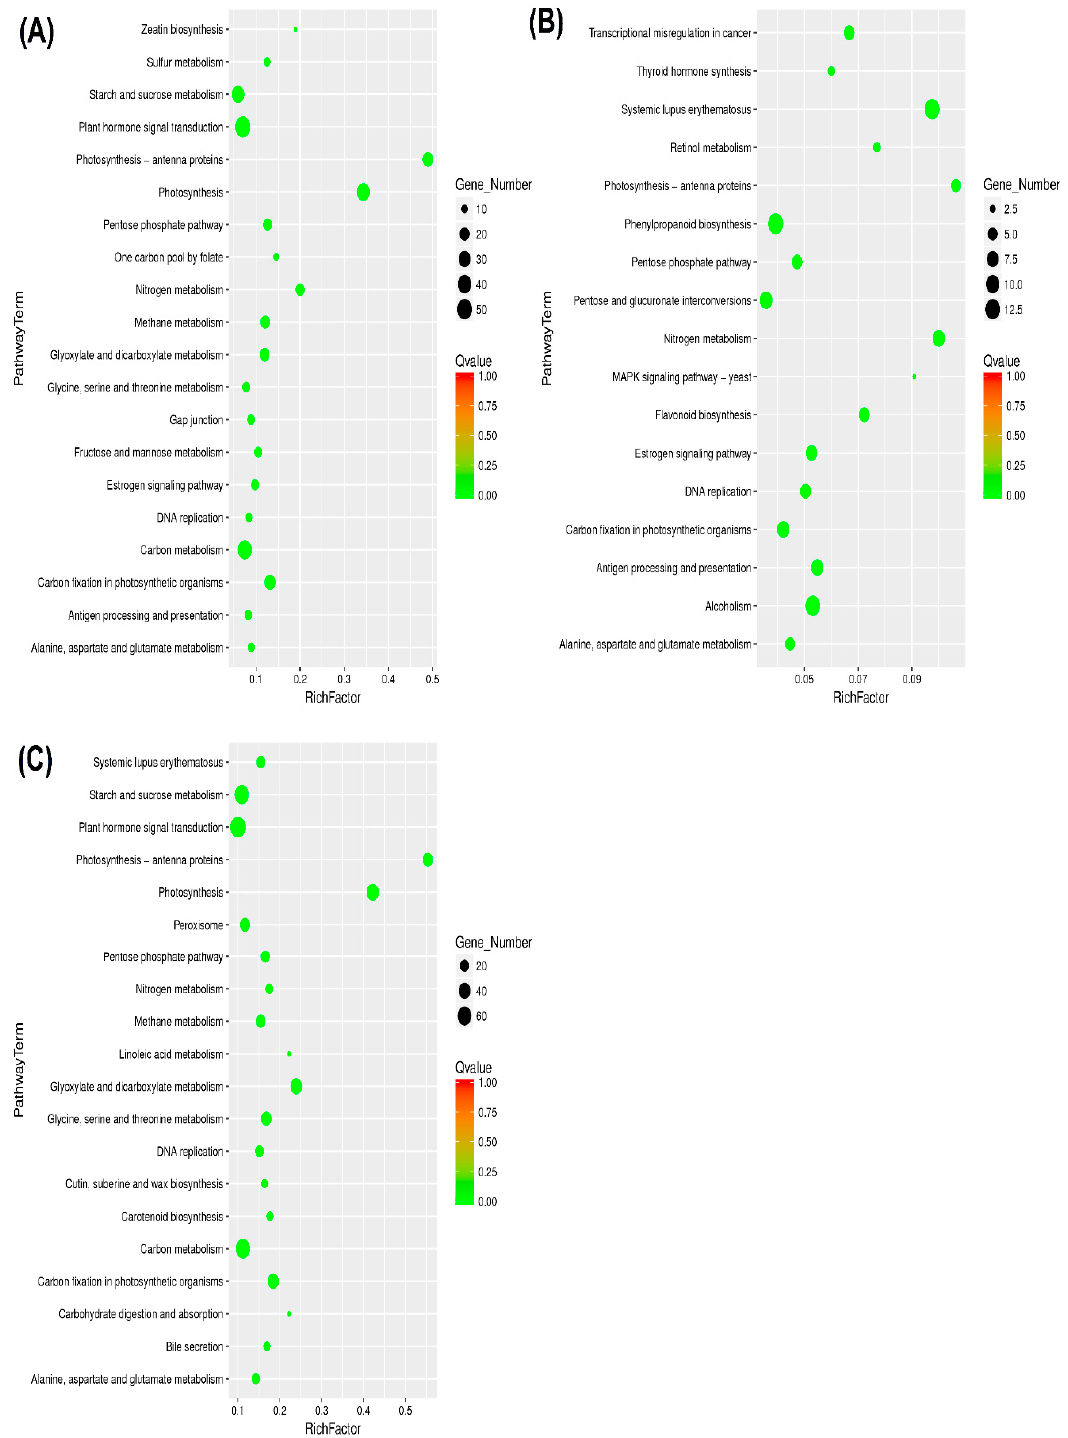
Figure 5. Scatter plot of KEGG pathway enrichment statistics. Here, ( A ) TM-1 control and drought, ( B ) Zhongmian-16 control and drought, and ( C ) Pima4-S control and drought. Rich Factor is the ratio